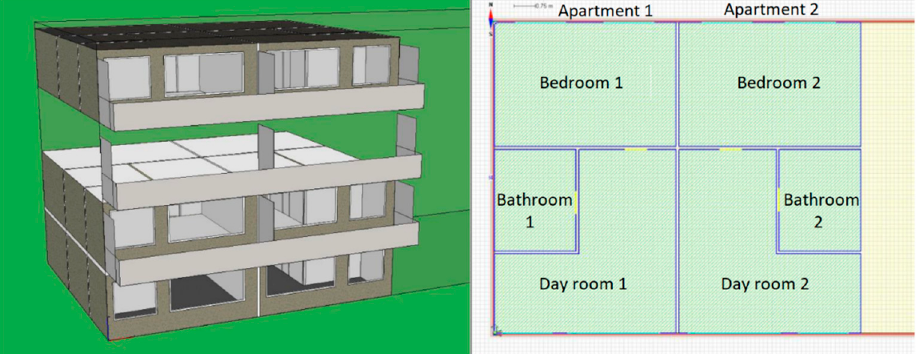
Figure 1. Left : Model from 3D-view IDA ICE and right : floor plan for two apartments, each with three zones.